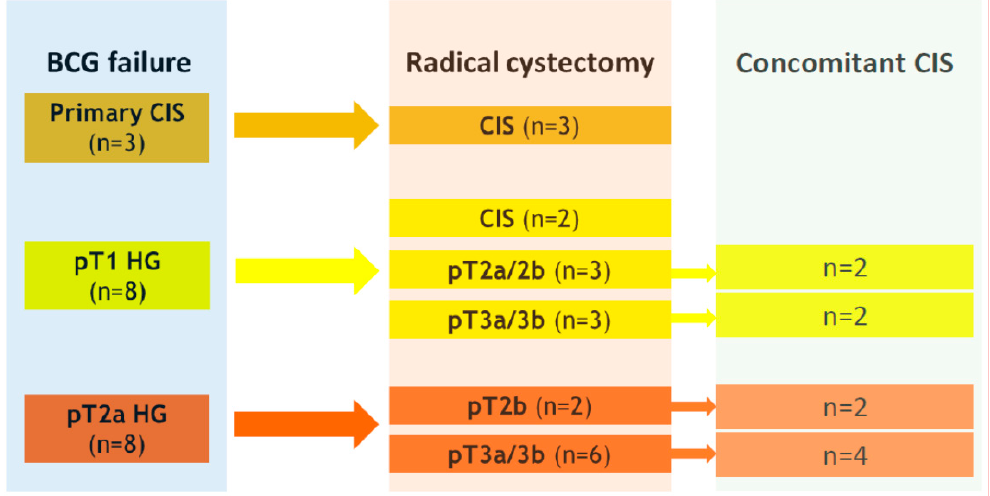
of eight pT1 HG tumors at BCG failure, respectively (Figure 2). Overall, five patients (28.3%) had positive pathological lymph node status (pN+), and nine patients (47.3%) confirmed extravesical disease at final histology on RC specimens.